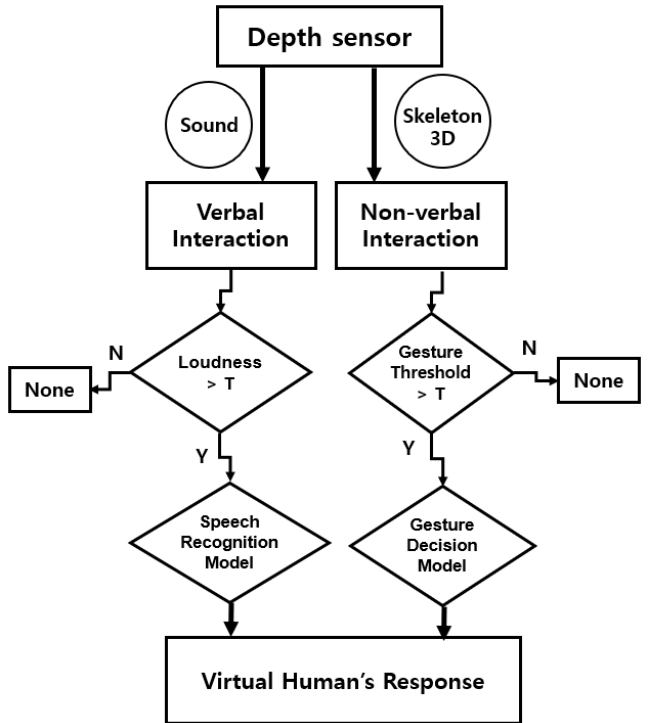
Figure 2. Verbal and non-verbal interaction and response matching process of the virtual human.